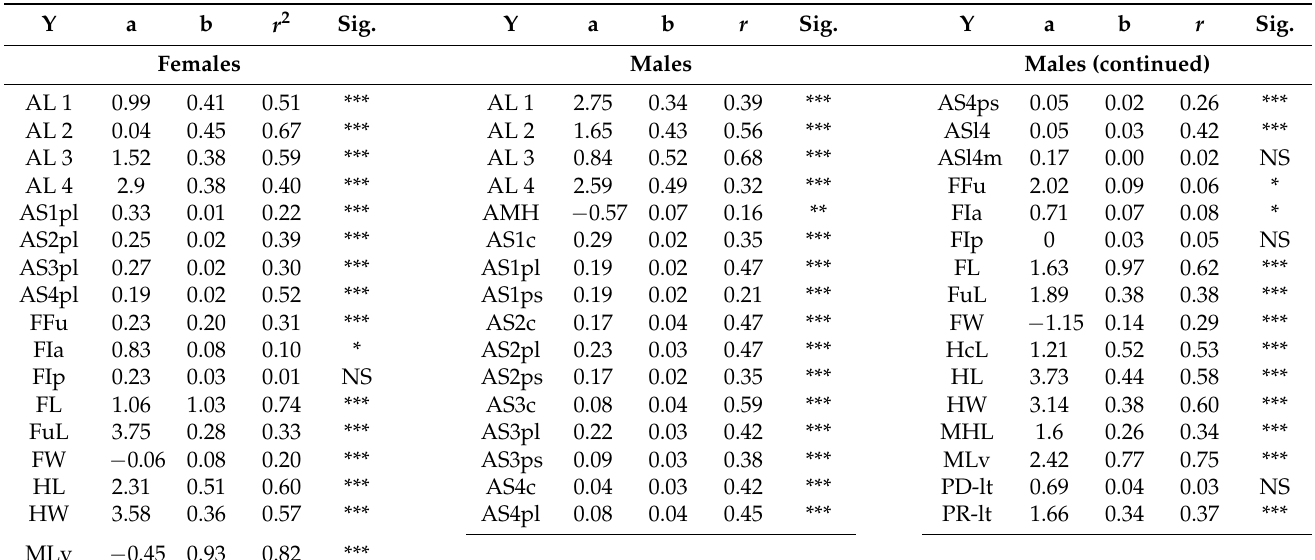
Table A6. Univariate regression equations (Y = a + bML) used to calculate residuals, where a = intercept, b = slope, ML = mantle length, r 2 = correlation coefficient of the regression, and Y = the predicted value of that dependent variable. Sig. is the significance of the regression